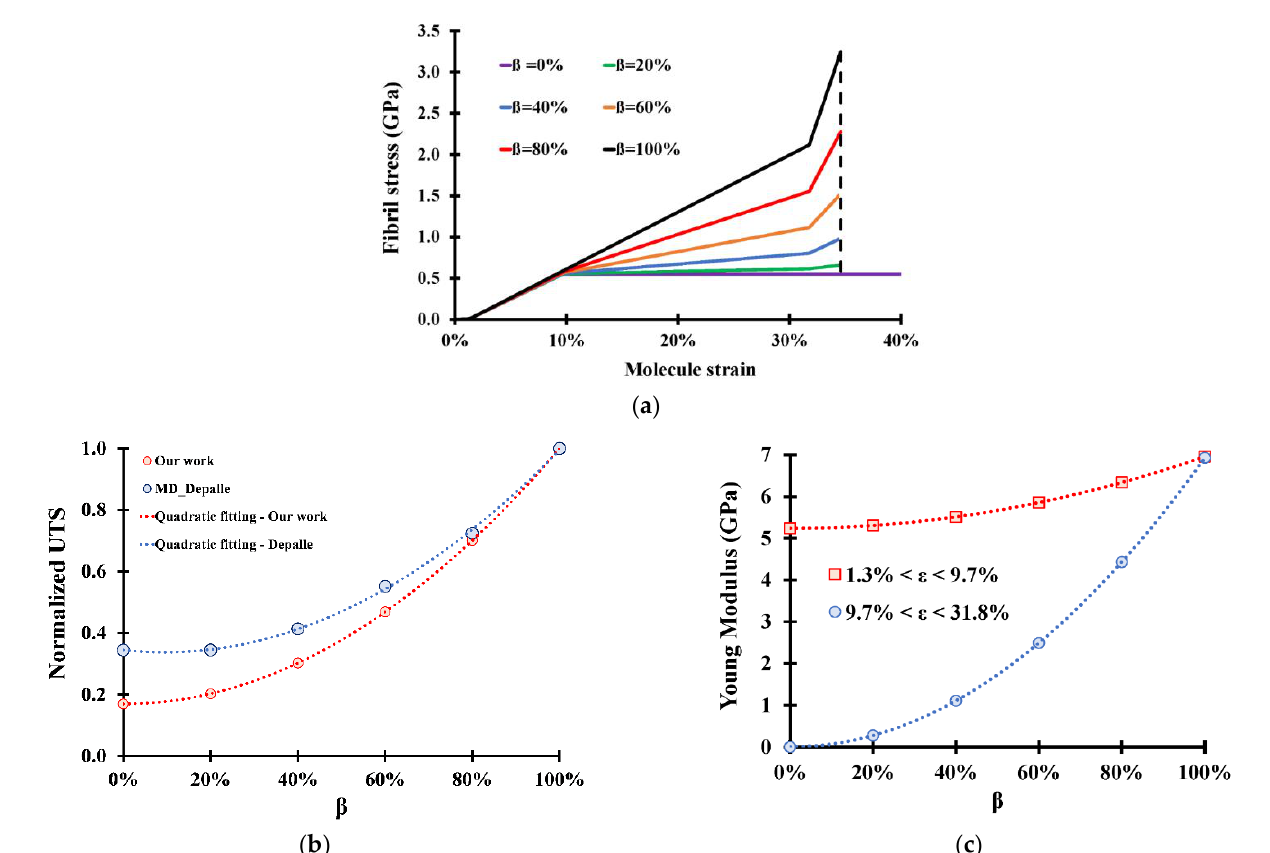
Figure 7. Partially crosslinked collagen fibril response to tensile load: ( a ) stress–strain curve for a partially crosslinked collagen fibril; ( b ) variation of the fibril UTS with crosslink density (Depalle et al., [18]); ( c ) variation of fibril stiffness with crosslink density ( ∅ = 25 nm) .